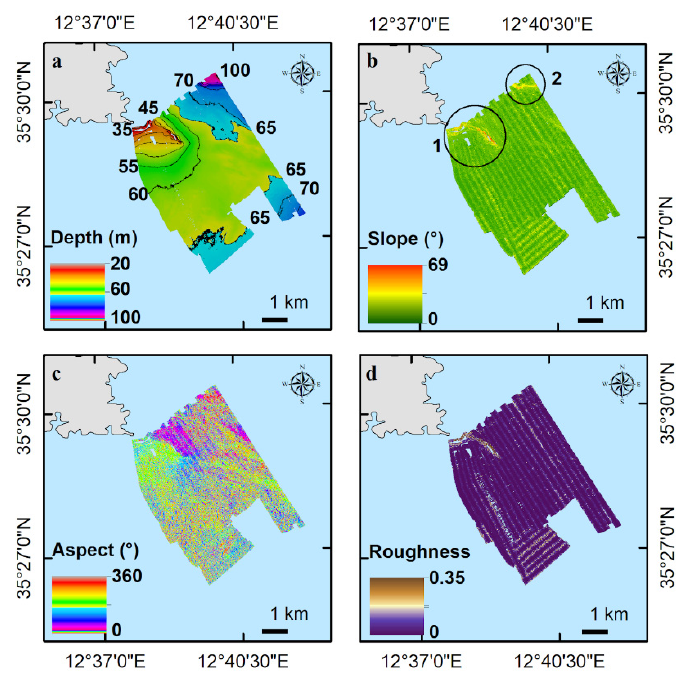
Figure 2. Terrain variables maps from Multibeam morpho-bathymetric surveys: ( a ) bathymetry map; ( b ) slope distribution map, in evidence the areas characterized by the presence of high morphologies; ( c ) aspect distribution map; ( d ) roughness distribution map.